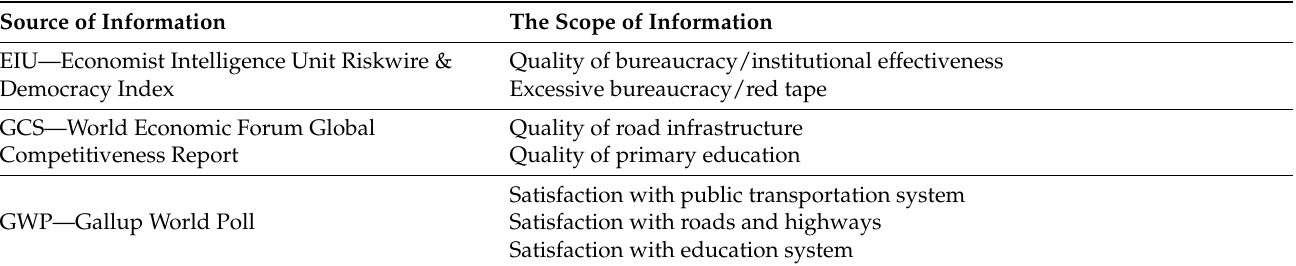
Table A1. Representative Sources of Global Government Effectiveness